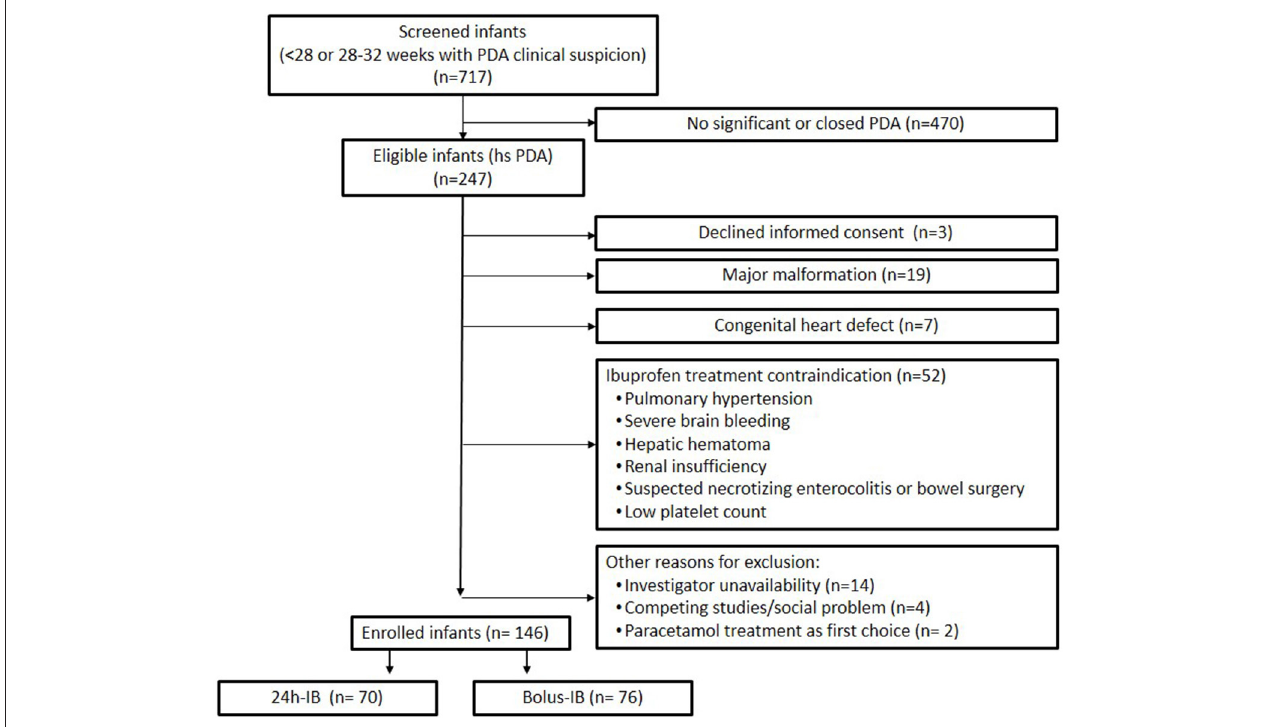
FIGURE 1 | Patient